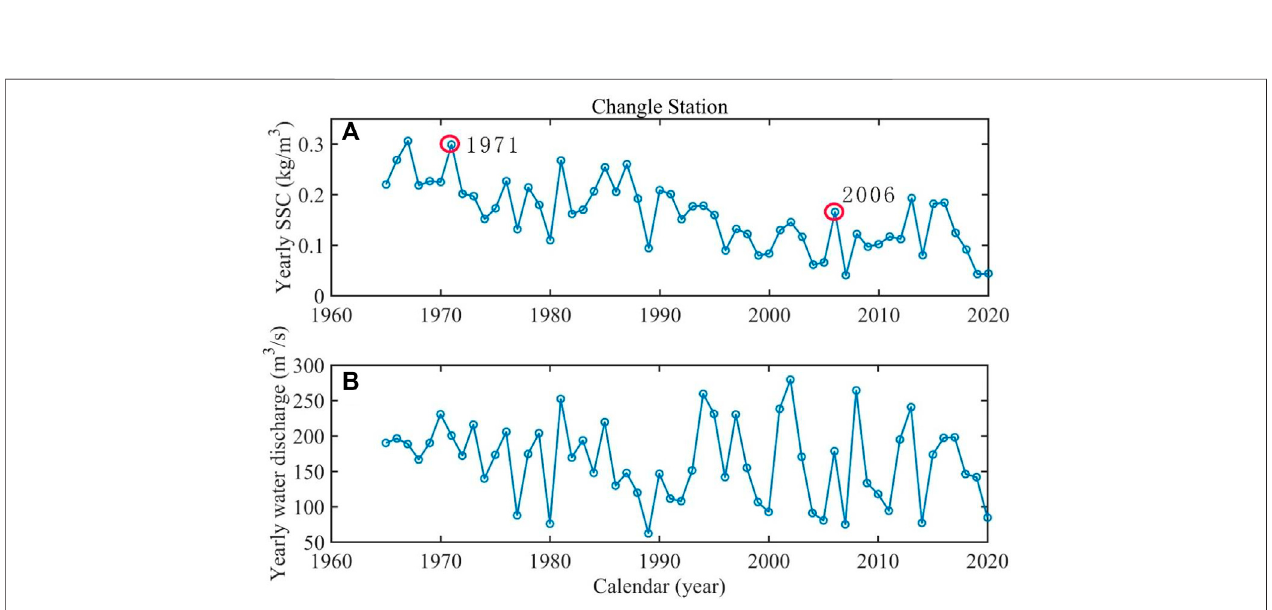
FIGURE3| VariationtrendoftheSSCandwaterdischargeattheChangleStationfrom1965to2020 (A) variationintheyearlySSC; (B) variationintheyearlywater discharge.